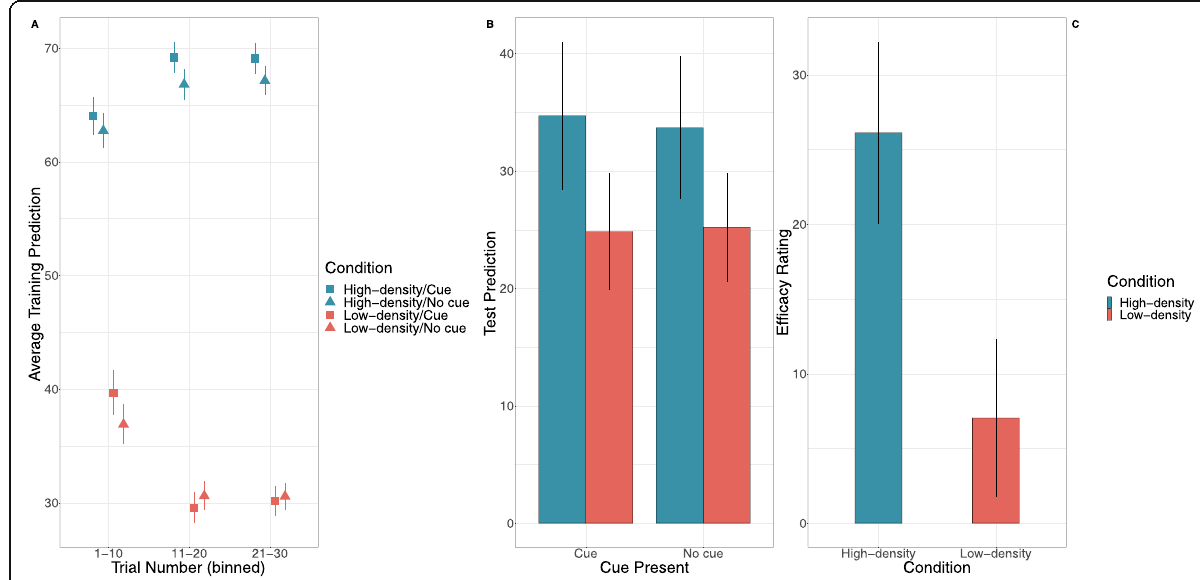
Fig. 6 Results from Experiment 2 for a training predictions as a function of outcome density condition, cue presence, and trial as well as b predictions of students ’ average performance as a function of outcome density condition and c efficacy ratings as a function of outcome density condition. Error bars represent + 1 standard error of the